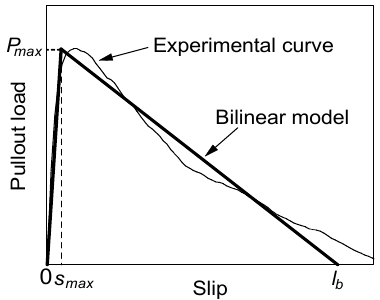
Figure 13. Bilinear model for pullout load–slip curve.